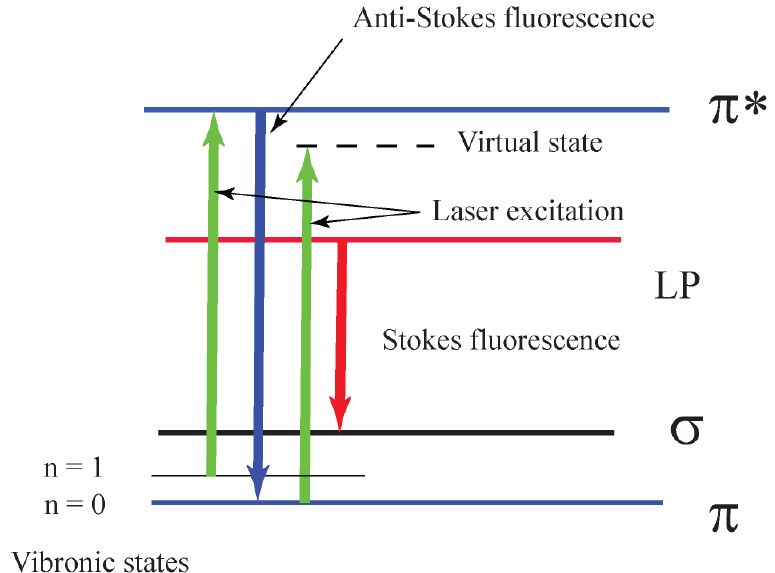
Figure 5. Schematic energy level diagram of the fluorescence emission from s -C 3 N 4. This diagram can be considered as a combination of the simplified energy level diagram described in Ref. [22] and that discussed in Ref. [10]. When the laser intensity is low, we observe stock fluorescence excited by a green laser with a peak centered at 582